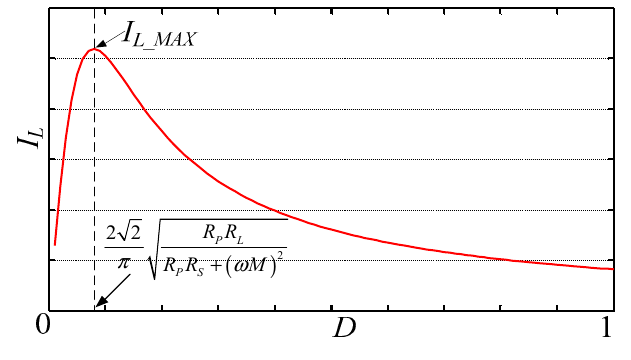
Figure 4. The relationship between D and I L .